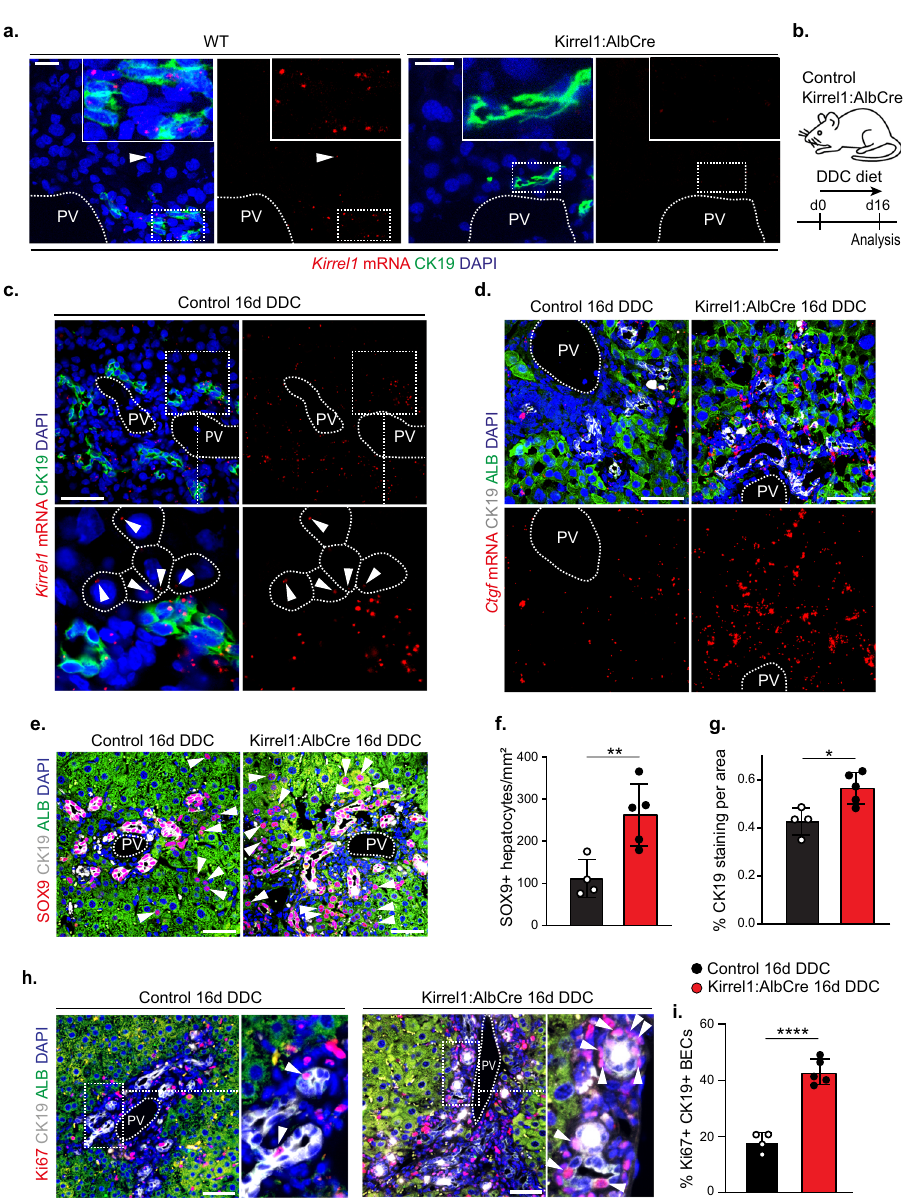
Fig. 6 KIRREL1 restricts YAP/TAZ activity during ductular reaction (DR) in mice. a Kirrel1 ISH co-staining with the BEC marker CK19 in Kirrel1:AlbCre and WT control mice. PV portal vein. Arrowheads indicate Kirrel1 ISH signals in periportal hepatocytes. Scale bar, 50 µ m. b Scheme depicting 16 days DDC diet injury in Kirrel1:AlbCre and control mice. c Kirrel1 ISH co-staining with CK19 in control mice 16 days post DDC diet. PV, portal vein. Arrowheads indicate Kirrel1 ISH signals in encircled hepatocytes. Scale bar, 100 µ m. d ISH for the YAP target gene Ctgf co-stained with CK19 and the hepatocyte marker Albumin (Alb), showing increased YAP signaling during DDC-induced DR in Kirrel1:AlbCre mice. PV, portal vein. Scale bar, 100 µ m. e – g Co-staining for CK19, ALB, and SOX9 ( e ) in the indicated mice (arrowheads mark SOX9 + hepatocytes). Quanti fi cation indicates increased numbers of SOX9 + hepatocytes ( f ) and the percentage of CK19 staining per area ( g , normalized to number of portal veins in the analysis area) in Kirrel1:AlbCre compared to control mice following 16 days DDC diet (IHC stainings used for quanti fi cation are provided in Fig. S6e). Data represent mean ± SD. Two-tailed unpaired t -test was used with groups of n = 4 control and n = 5 Kirrel1:AlbCre mice (6f, g). p values are 0.0090 (**, f ), 0.0125 (*, g ). Scale bar ( e ), 100 µ m. h , i Co-staining for Ki67, CK19, and ALB ( h ) and quanti fi cation ( i ) indicates increased number of proliferating Ki67 + CK19 + BECs (arrowheads) in Kirrel1:AlbCre compared to control mice. PV portal vein, Data represent mean ± SD. Two-tailed unpaired t -test was used with groups of n = 4 control and n = 5 Kirrel1:AlbCre mice. p value is 0.00009 (****, i ). Scale bar, 100 µ m ( h are integrated to regulate cell growth 39 . The discovery of NF2/ as the discovery engine for the fi eld. On the other hand, although Merlin and Expanded provided the fi rst indication of how junc- the core components are highly conserved between Drosophila tional proteins play critical roles in the Hippo pathway 29 . Since and mammals, upstream regulators of the Hippo pathway are less then, several tight and adherent junction proteins, as well as cell conserved. Systemic loss-of-function screens of mammalian polarity complex proteins have been discovered as upstream Hippo pathway to identify upstream regulators are limited. Well- regulators of the Hippo pathway 40 – 46 . The Hippo pathway was based siRNA screening is not ideal for Hippo signaling; as Hippo fi rst identi fi ed in Drosophila and since then the fruit fl y has served signaling is regulated by cell density, cells with decreased